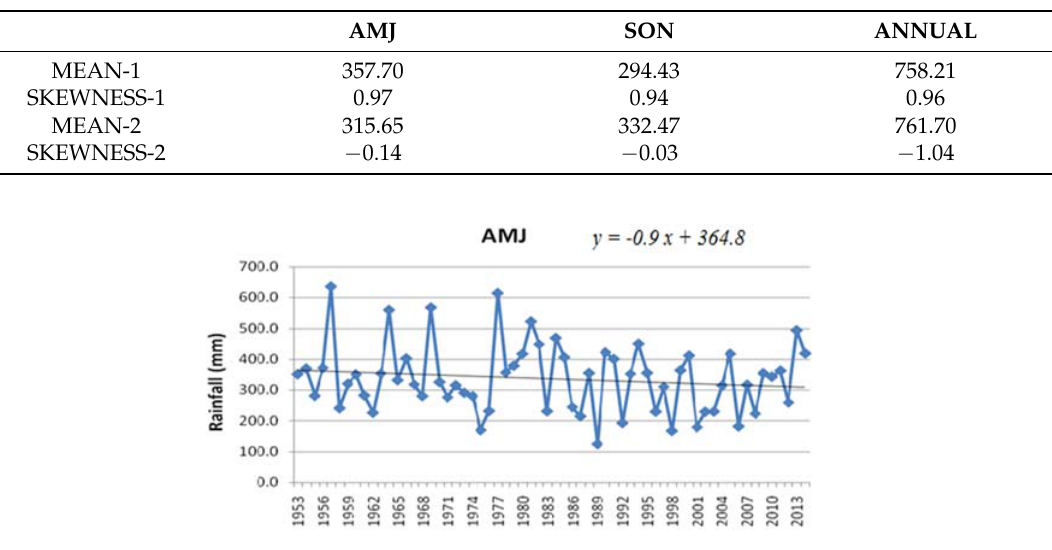
Figure 2. The time series of the April–June seasonal rainfall.